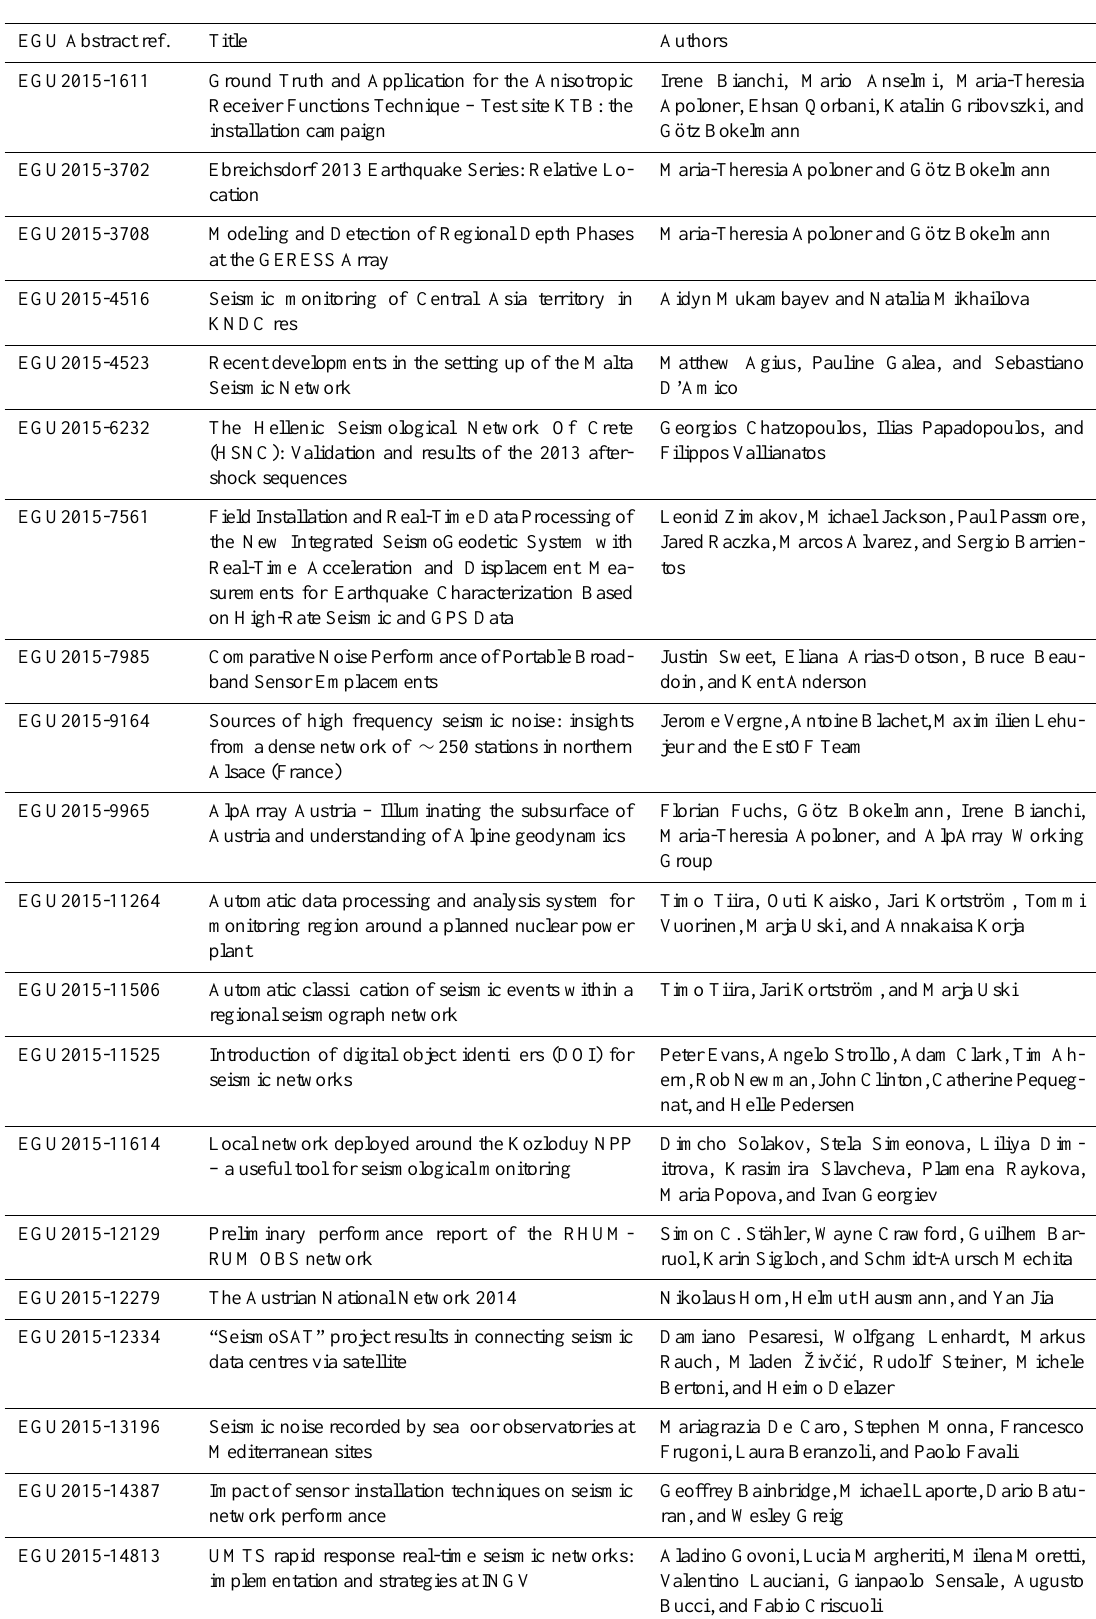
Table 1. Poster programme for the EGU2015 SM1.2/GI1.5 session. EGU Abstract